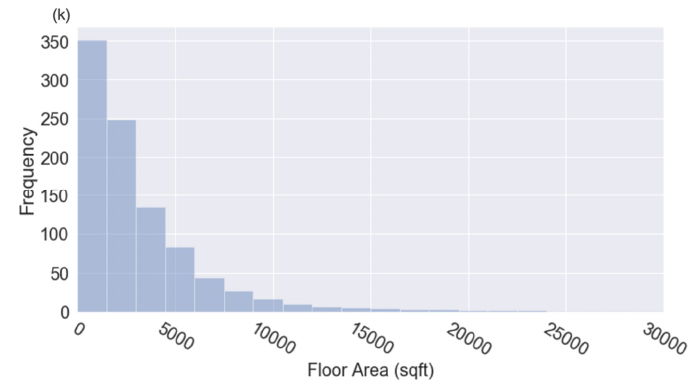
Figure 3. Floor area distribution of all buildings in the city of LA.